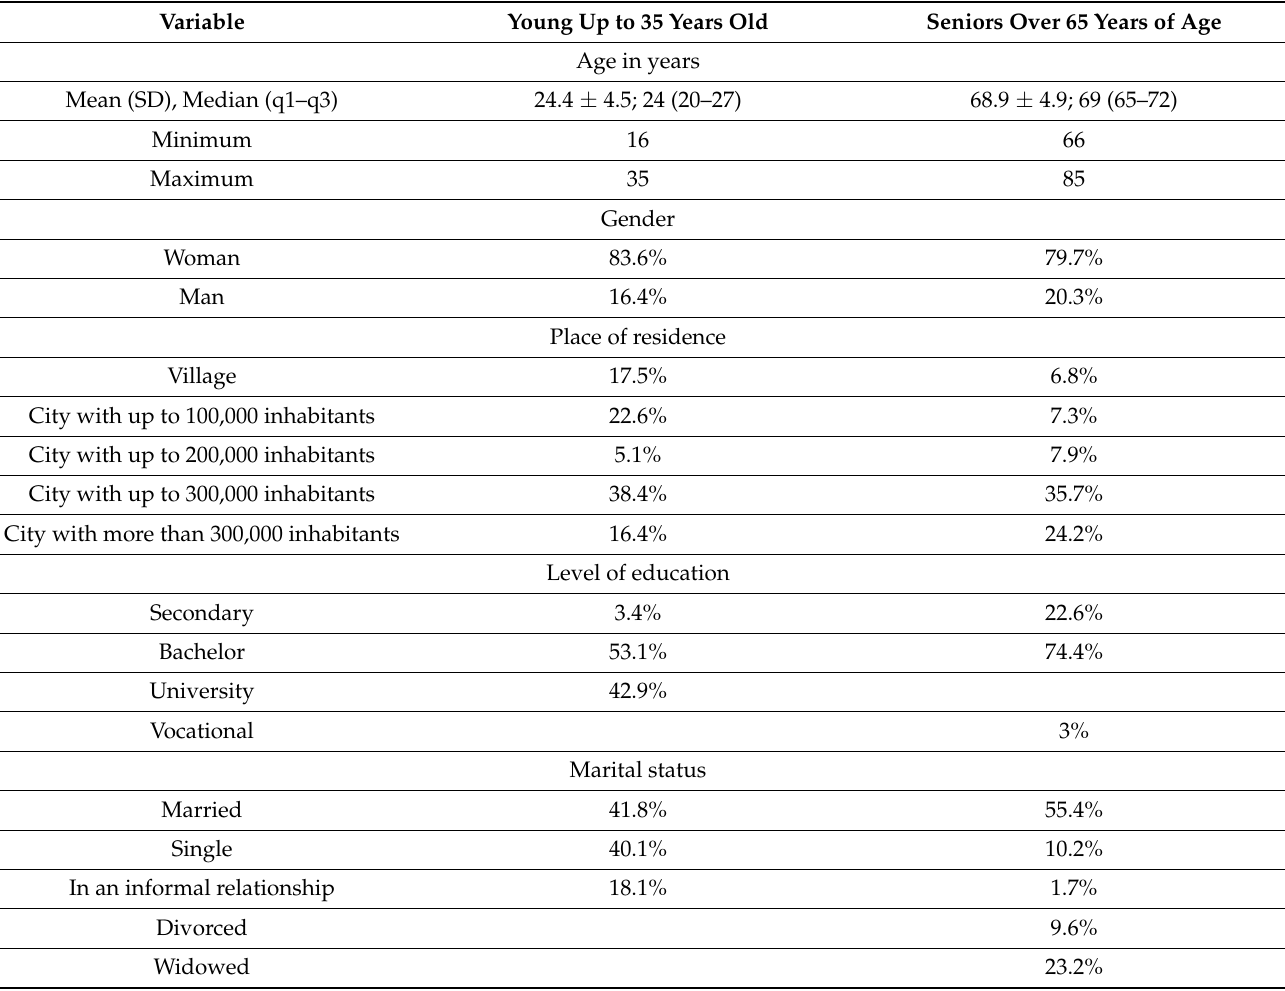
Table 1. Demographic data of the studied